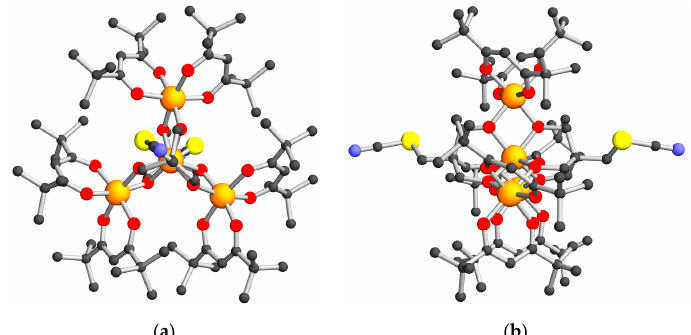
Figure 1. Molecular structure of 1 viewed along ( a ) and perpendicular to ( b ) the idealized three-fold axis. Color code: C = black, N = blue, O = red, S = yellow, Fe = orange. Minority components of disordered t Bu groups and hydrogen atoms have been omitted.